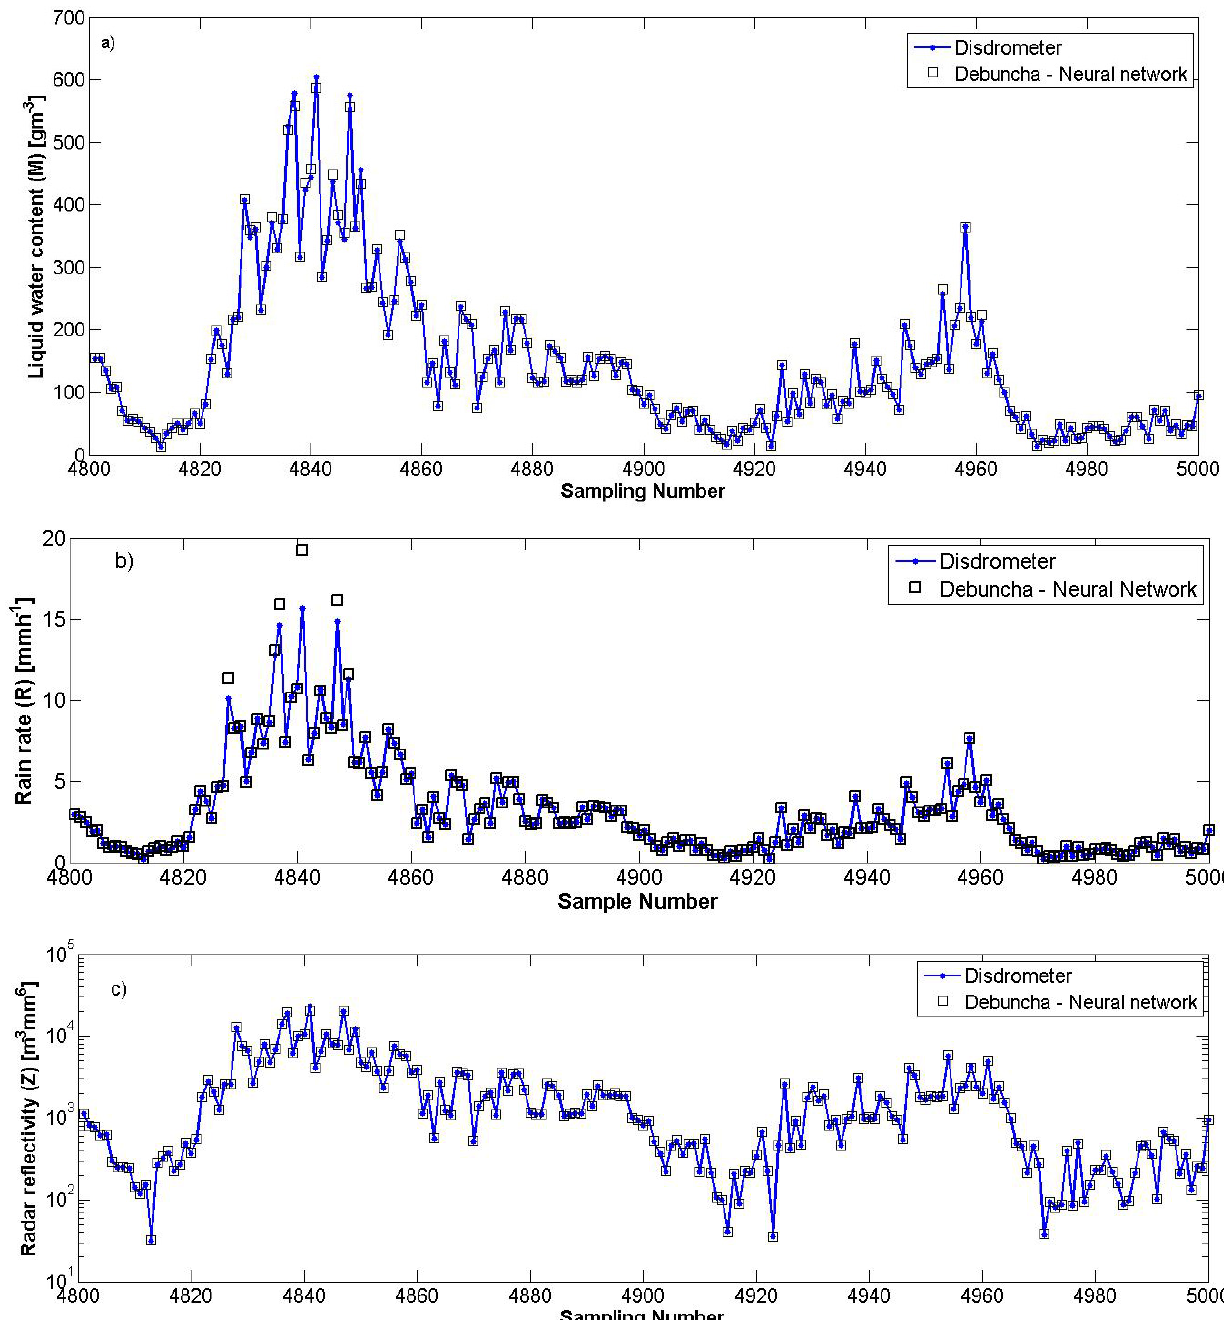
Figure 8. Neural prediction in Abidjan (Ivory Coast) of the liquid water content M ( a ), the rain rate R ( b ) and the radar reflectivity Z ( c ) by a LANN constructed with data issued only from Debuncha